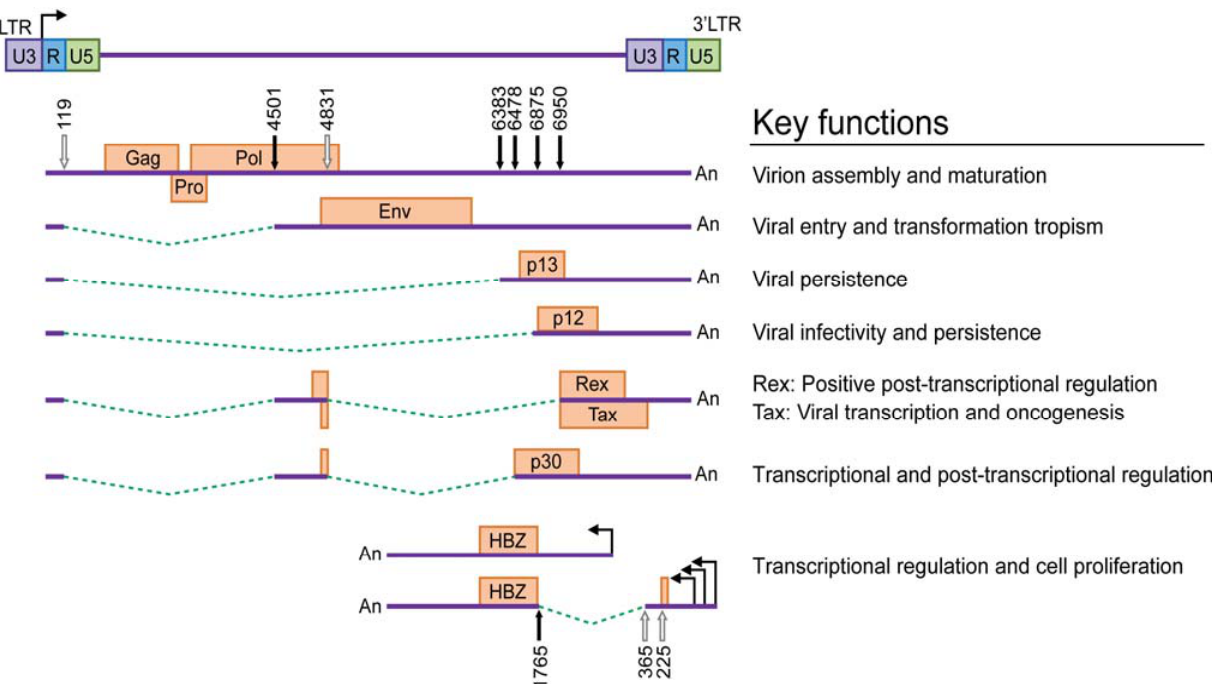
Figure 1. Structure of the HTLV-1 proviral genome and gene product key functions. The proviral DNA with the LTRs, and the unspliced, singly spliced and doubly spliced mRNA transcripts are shown to scale. The names of the gene transcripts are depicted inside each specific box (protein coding sequence). Solid lines indicate the exons and the dotted lines indicate the introns. Splice donor sites are indicated by open arrows and major splice acceptor sites are indicated by closed arrows. The numbers represent the nucleotide positions relative to the viral RNA. The general key functions for each of the genes at the protein level are listed to the right (see text for